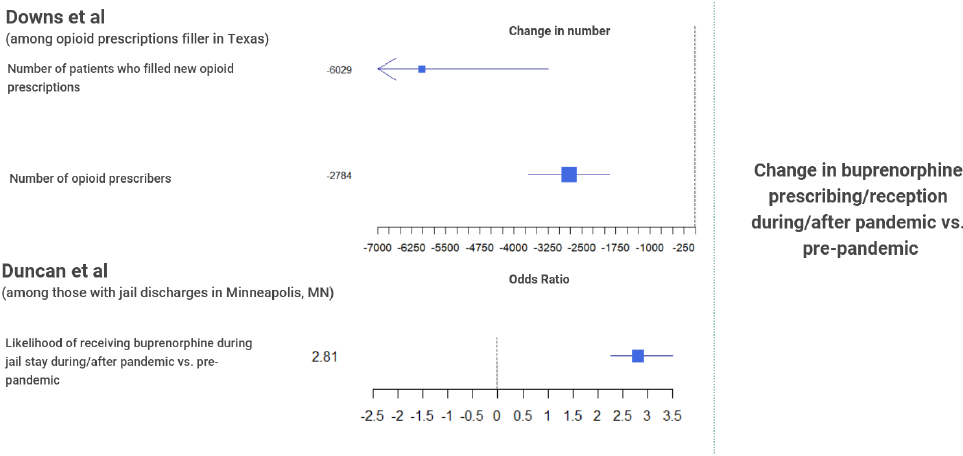
Figure 6. Summary evidence for changes in substance use treatment and harm reduction services access. MN = Minnesota